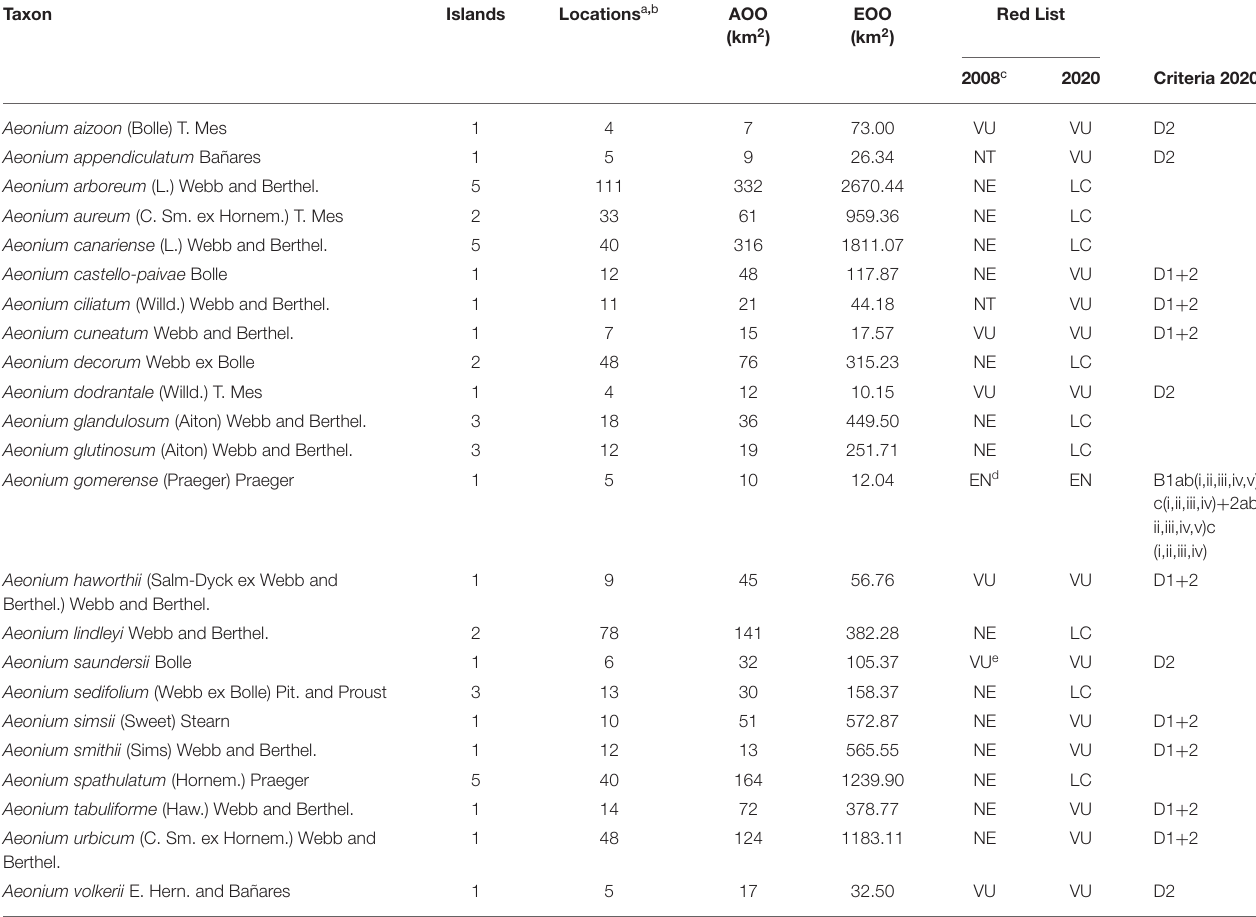
TABLE 1 | Assessment of conservation status of the 23 Aeonium species from Canary and Madeira Islands and Red List categories, criteria, and the main parameters used.